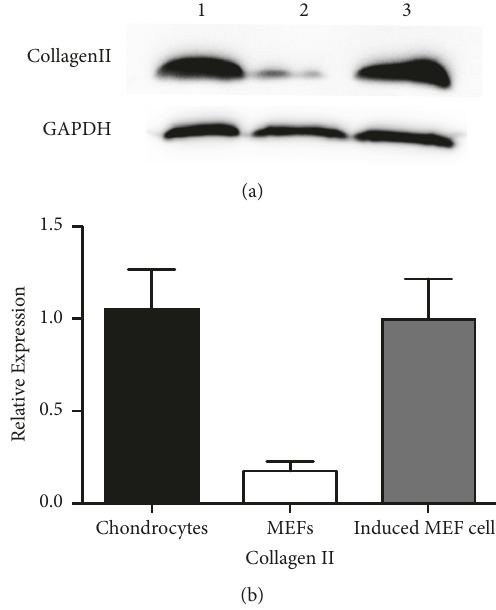
Figure 7: Col2 𝛼 1 expression measurement: (a) Western blot, Lane 1: induced MEF cells, Lane 2: MEF cells treated with pmPPY only. (b) A quantitative analysis of the relative expression levels of Col2 𝛼 1 (mean ± standard deviation of measurements from three replicates) ∗∗ P <